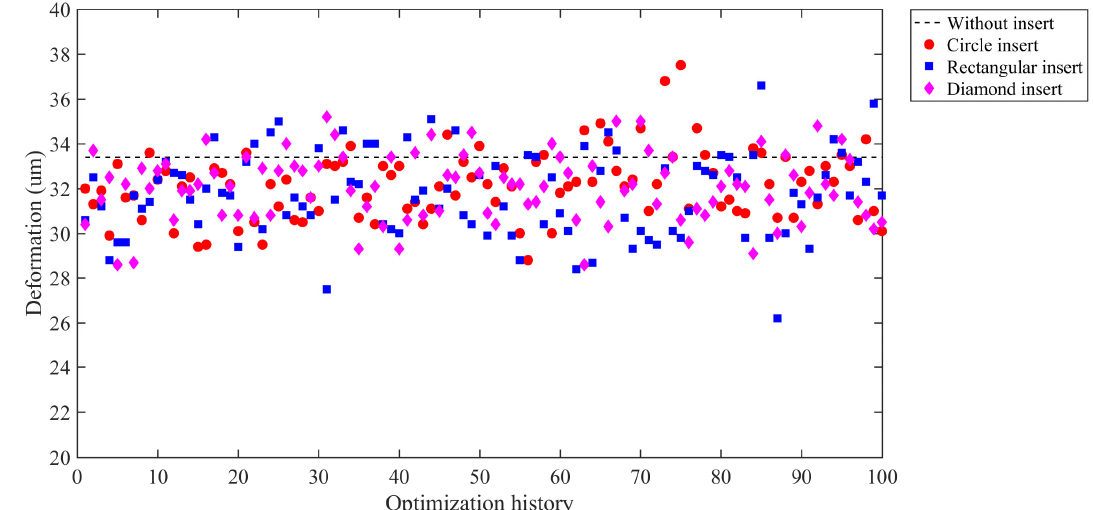
Figure 7. Appearance quality optimization history of different shape inserts.